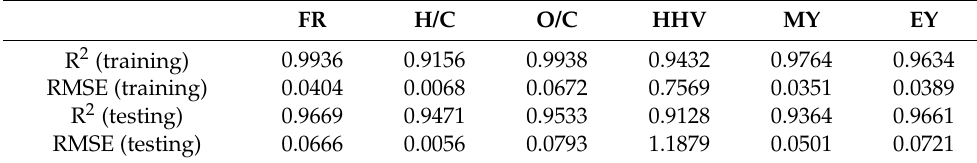
Table 1. R 2 and RMSE results of the training and testing set using the GA-BPNN model.